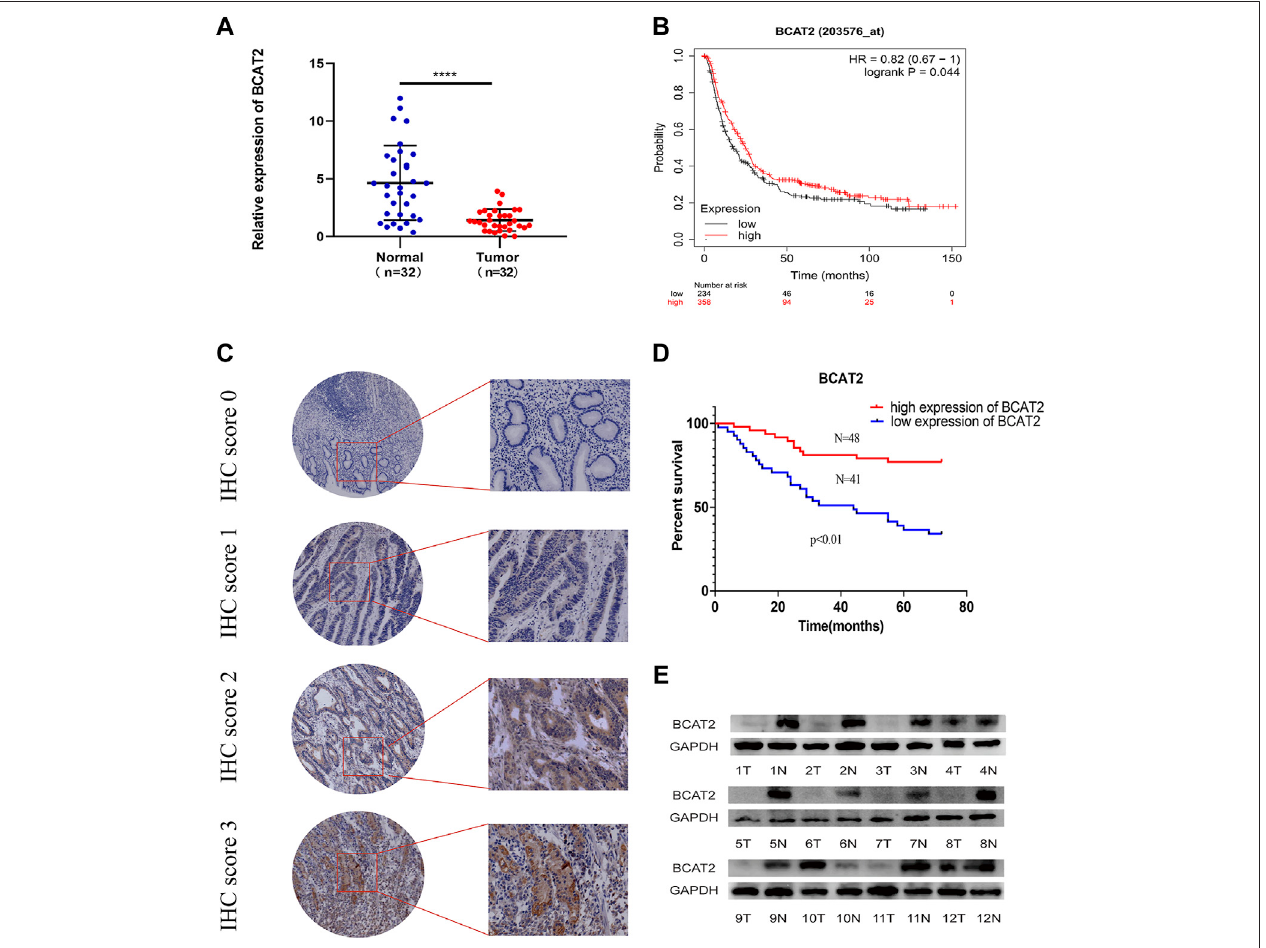
FIGURE 5 | Low BCAT2 expression in GC. (A) Relative expression of BCAT2 in 32 paired GC tissues and matched adjacent normal samples via qRT-PCR. ( p < 0.05). (B) ThesurvivalcurveofBCAT2inGCpatientsfromtheKaplan – Meierplot( p < 0.05). (C) IHCstainingoftheBCAT2proteininGCtissues. (D) Thesurvivalcurveof BCAT2 in GC patients using the IHC staining score ( p < 0.05). (E) The protein expression of BCAT2 in 12 paired GC tissues and matched normal adjacent mucosa, analyzed by western blotting. T, GC tissues; N, matched adjacent normal samples. * p < 0.05, ** p < 0.01, *** p < 0.001, **** p < 0.0001.